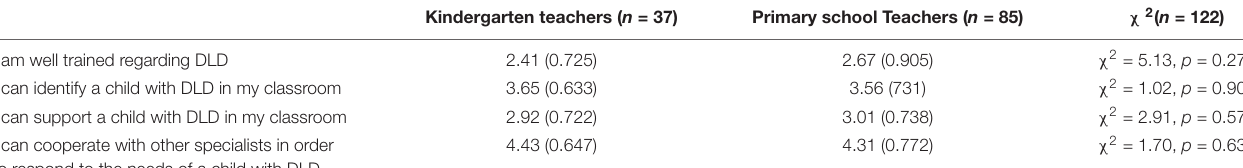
TABLE 5 | Mean (SDs) of teachers’ professional adequacy ( 1 = strongly disagree, 2 = agree, 3 = disagree, 4 = strongly disagree 5 = strongly agree ).